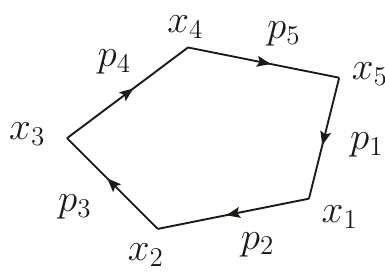
Figure 1 . Momenta and dual-momenta assignment to the five-cusp light-like Wilson loop contour.